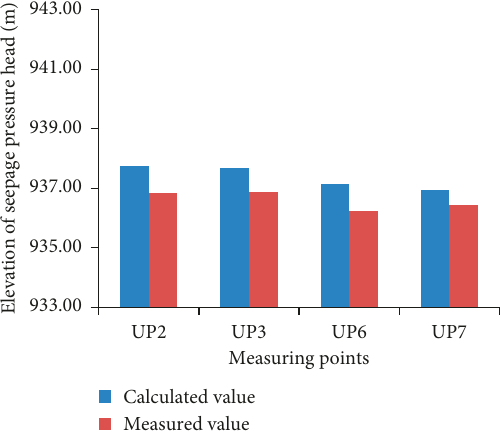
Figure 18: Comparison of calculated value and measured value in dry